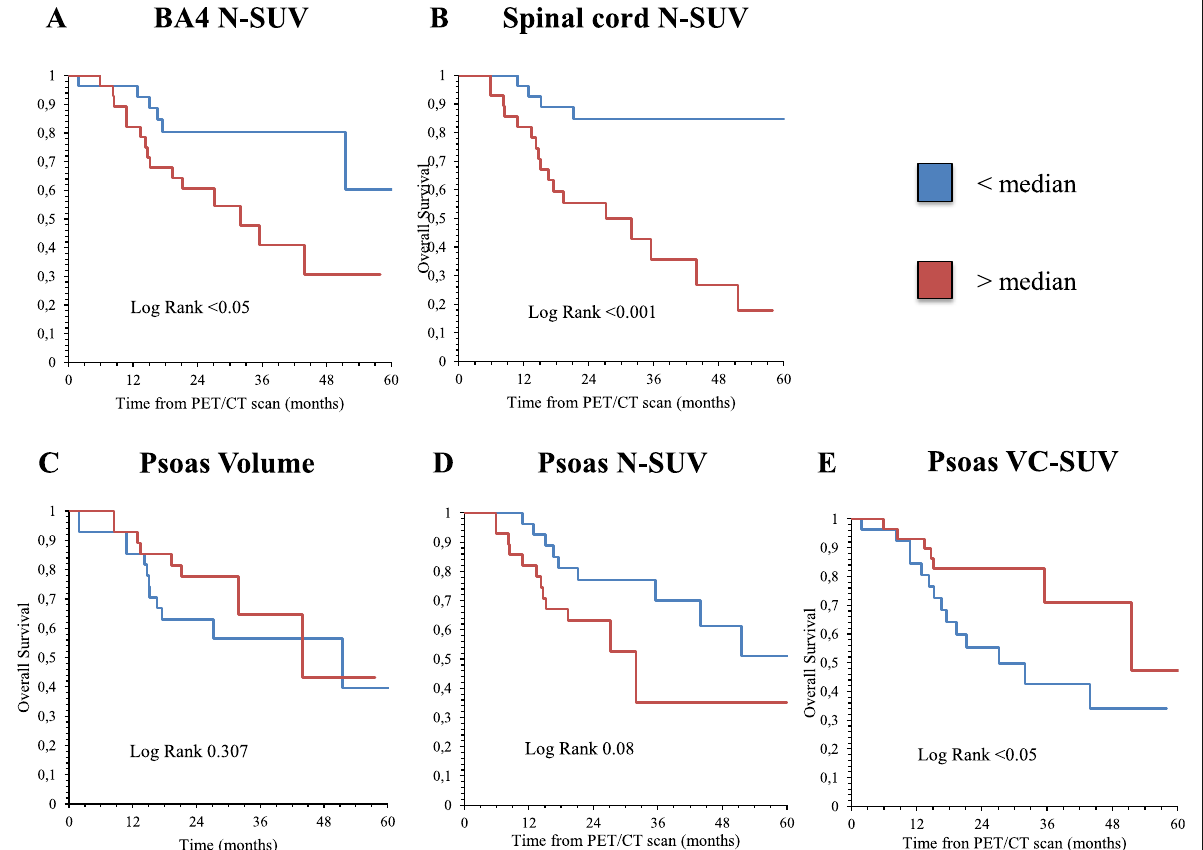
Fig. 4 Metabolic predictors of patient outcome. Kaplan – Meier curves in ALS patients based on FDG PET/CT-derived parameters are represented. Long-term OS from the PET/CT scan time-point is stratified based on spinal cord N-SUV ( a ), BA4 N-SUV ( b ), Psoas volume ( c ), psoas N-SUV, and psoas VC-SUV ( e ). Each subgroup is divided according to the